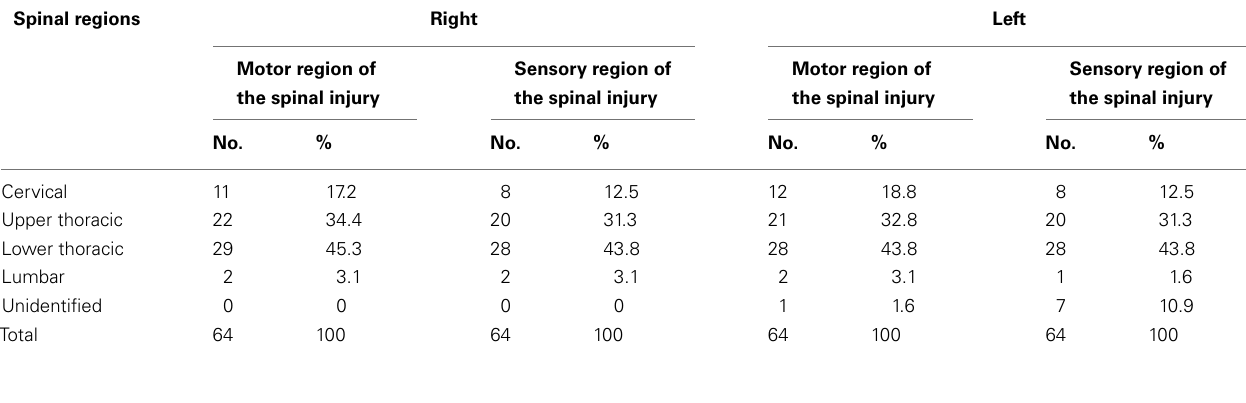
Table 1 | Motor and sensory distribution of the right and left spinal injury in SCIVeterans who were recruited in the study on EPPS application. Spinal regions